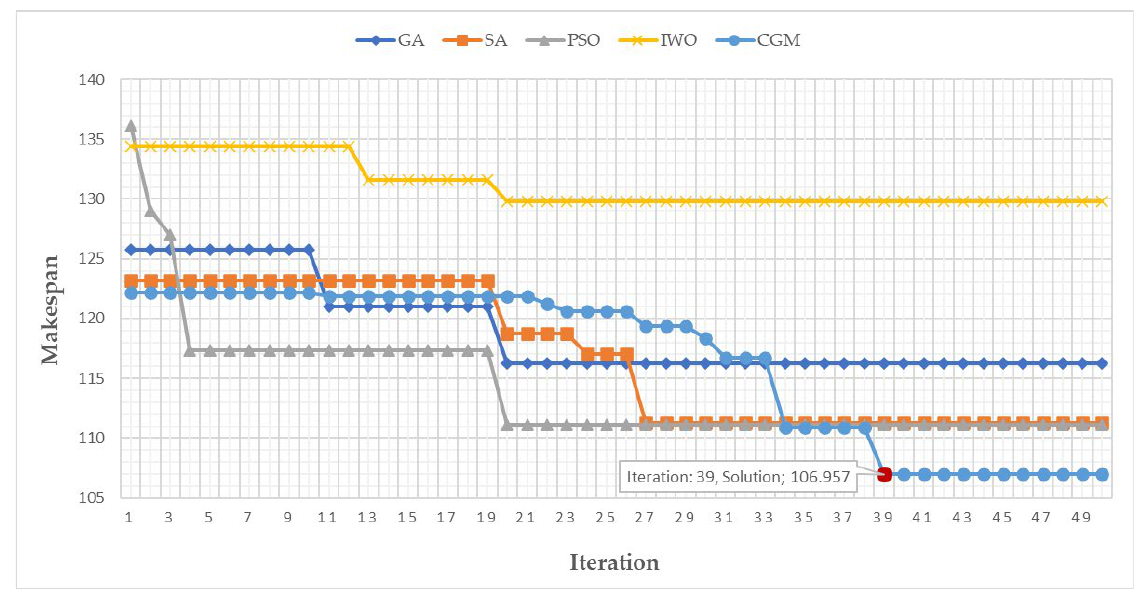
Figure 12. Investigation of convergence in different algorithms for the BoT scheduling problem (the number of tasks was 5000, and the number of computational resources was 200).